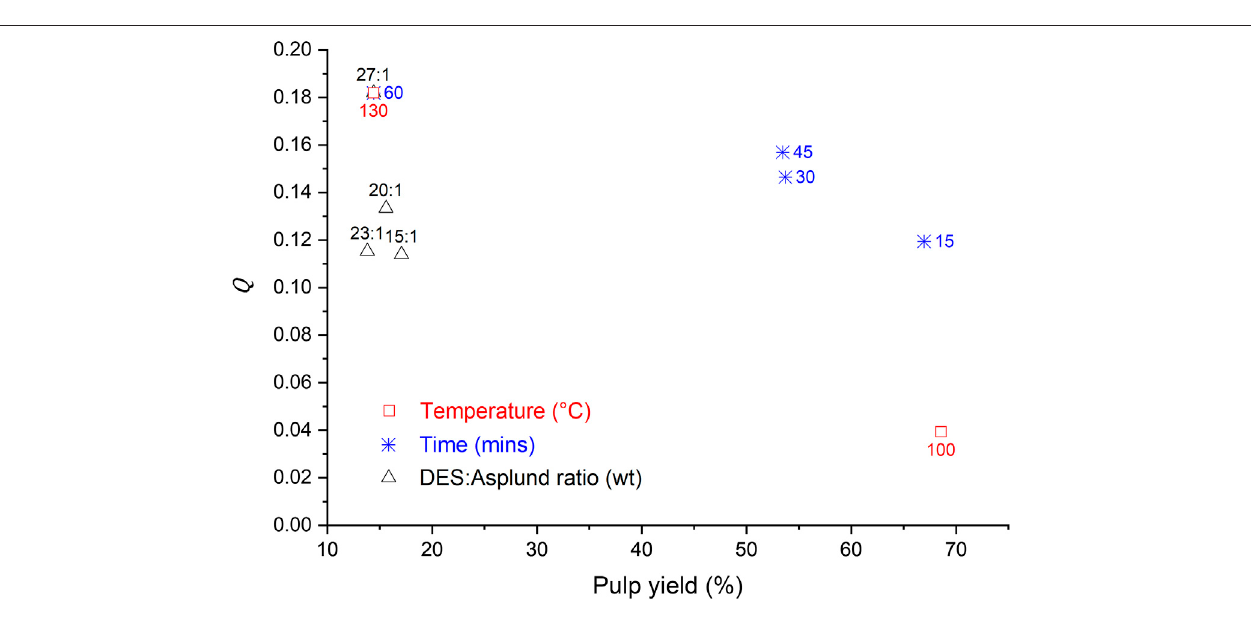
Frontiers in Chemistry |